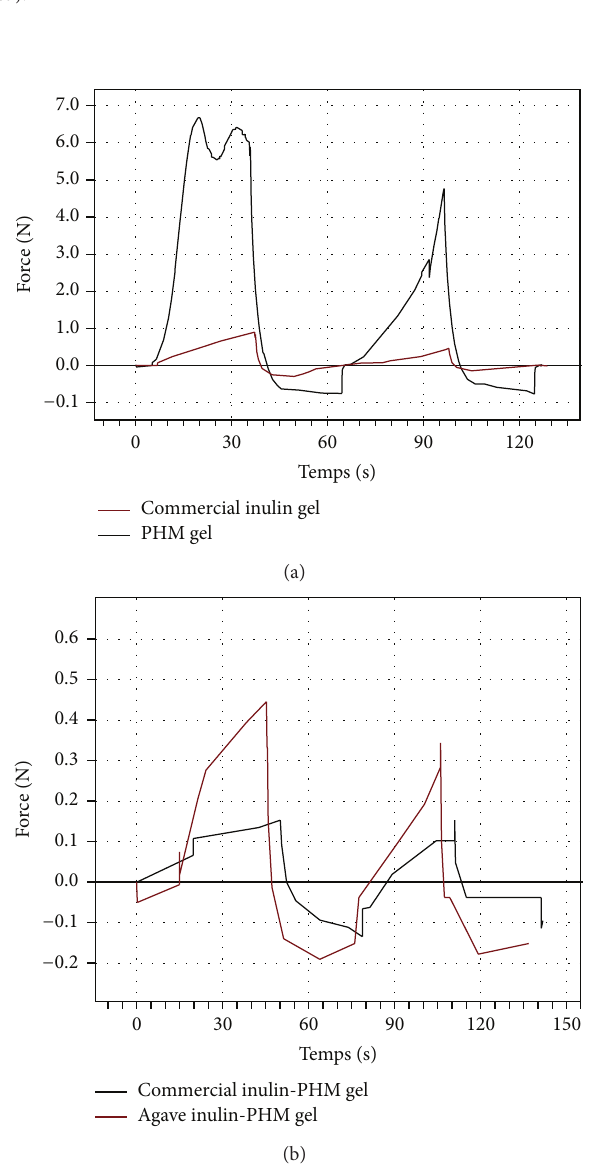
Figure 4: Texture profile of commercial inulin and PHM gels, commercial inulin-PHM, and Agave inulin-PHM